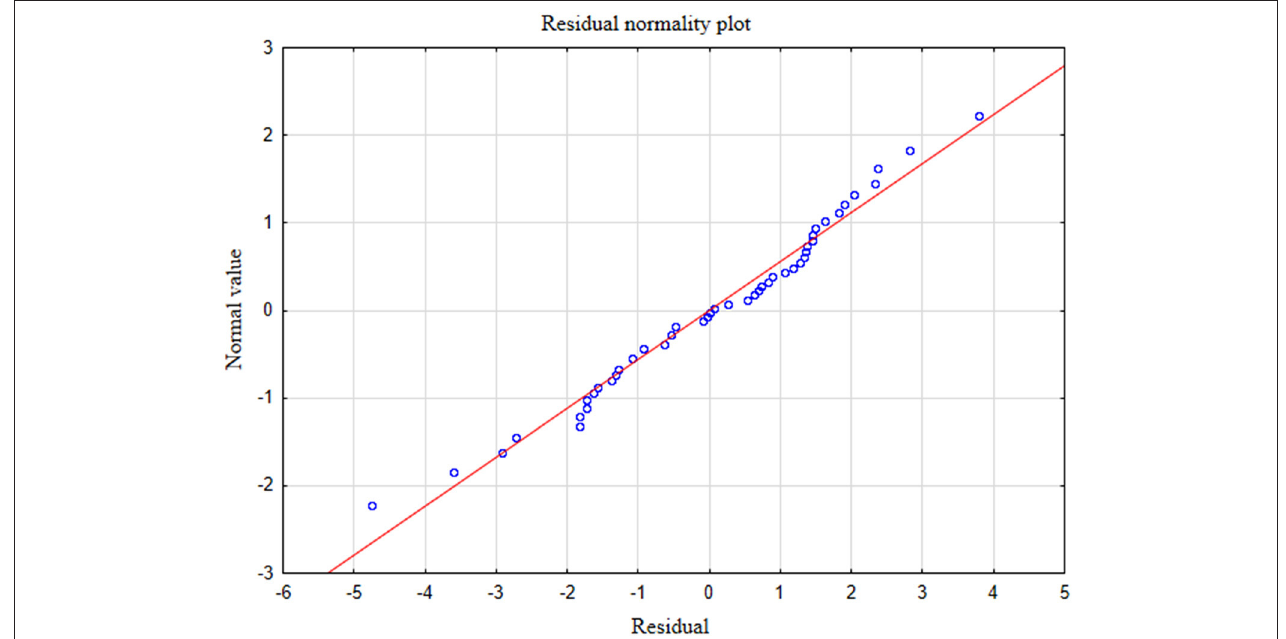
FIGURE 4 | Normality of the distribution of residuals with respect to multiple linear regression model for GAD-7